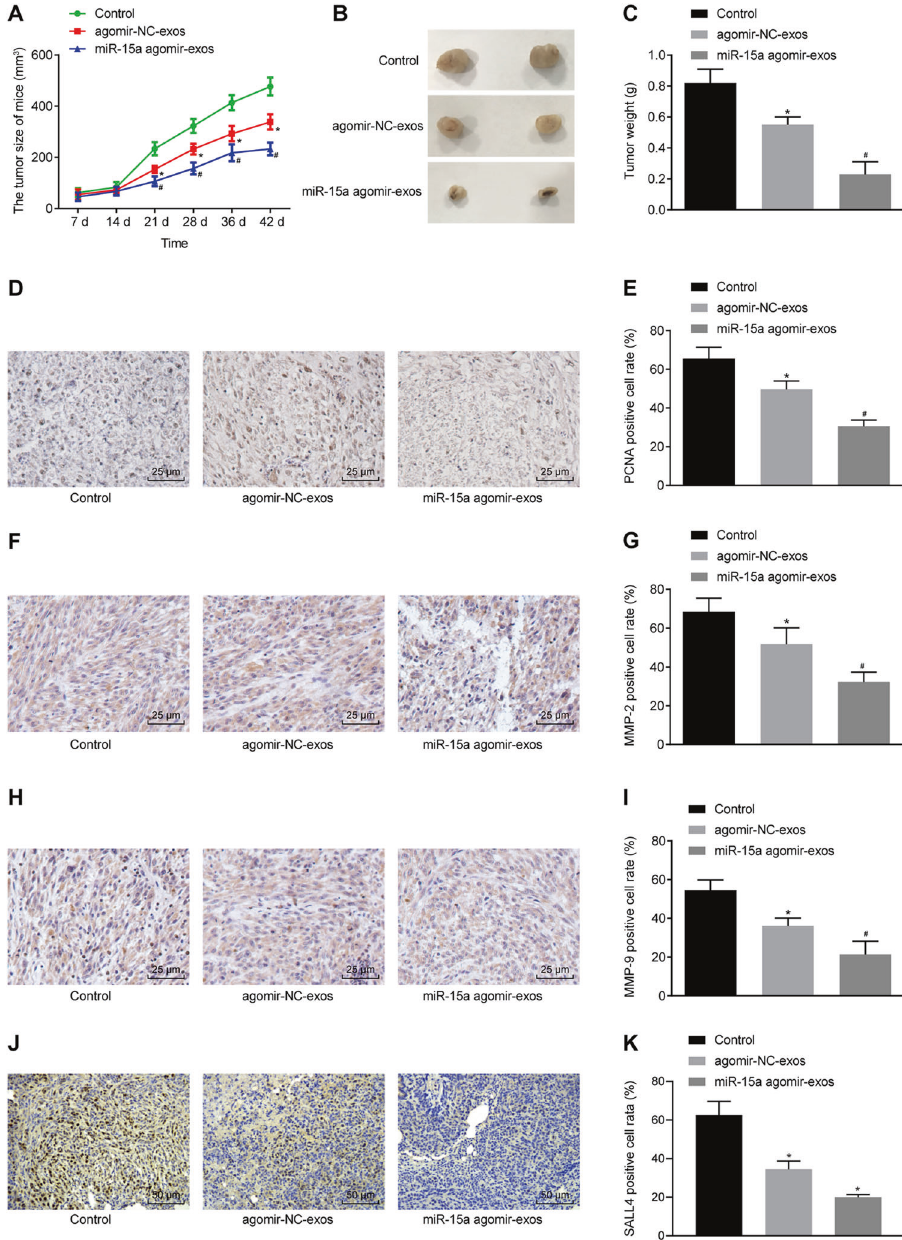
Fig. 6 Delivery of miR-15a by exosomes prevents tumor growth in vivo. A The growth of the HCC xenograft tumor was measured every 7 days in nude mice injected with Hep3B cells treated with miR-15a agomir-exos. B Macroscopic observation of xenograft tumor of nude mice injected with Hep3B cells treated with miR-15a agomir-exos. C Tumor weight of nude mice injected with Hep3B cells treated with miR-15a agomir-exos. D Positive expression rate of PCNA protein was examined by immunohistochemistry in tumor tissues of nude mice injected with Hep3B cells treated with miR-15a agomir-exos (×400). E The quantitation of panel D . F Positive expression rate of MMP-2 protein was examined by immunohistochemistry in tumor tissues of nude mice injected with Hep3B cells treated with miR-15a agomir-exos (×400). G The quantitation of panel F . H Positive expression rate of MMP-9 protein was examined by immunohistochemistry in tumor tissues of nude mice injected with Hep3B cells treated with miR-15a agomir-exos (×400). I The quantitation of panel H . J Positive expression rate of SALL4 protein was examined by immunohistochemistry in tumor tissues of nude mice injected with Hep3B cells treated with miR-15a agomir-exos (×400). K The quantitation of panel J . * p < 0.05 vs. control mice; # p < 0.05 vs. mice injected with agomir-NC-exos-treated Hep3B cells. Data in panel A were analyzed by repeated-measures ANOVA with Bonferroni test, and data in panels C , E , G , I , and K were analyzed by one-way ANOVA, with Tukey ’ s post-hoc test. n = 12 for mice following each